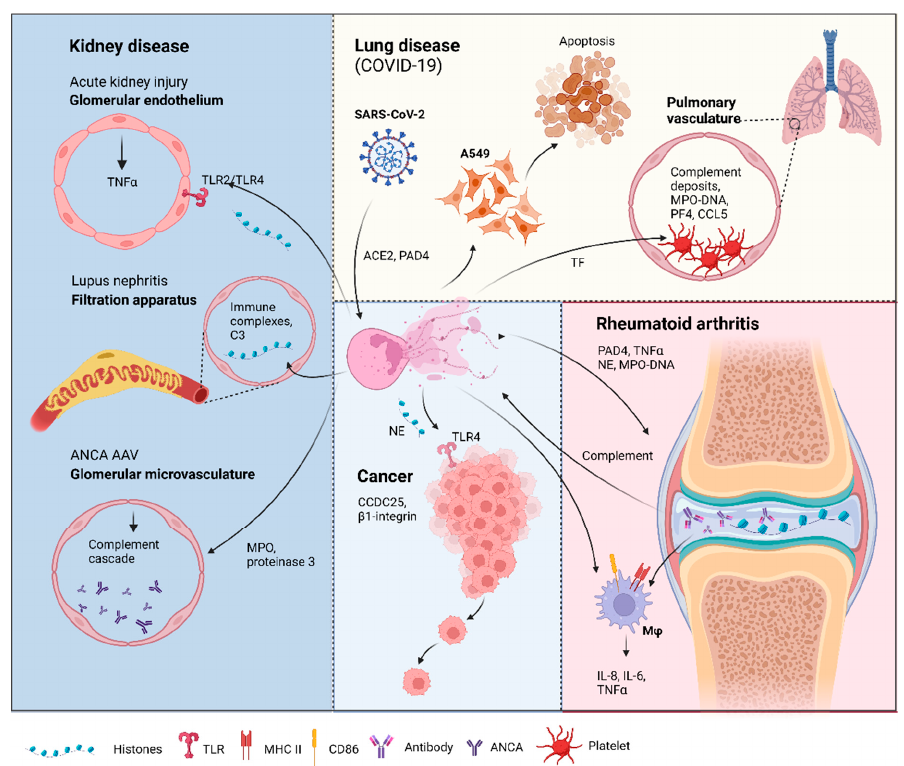
Figure 2. Neutrophil extracellular traps (NETs) in disease pathology. Acute kidney injury: NETosis